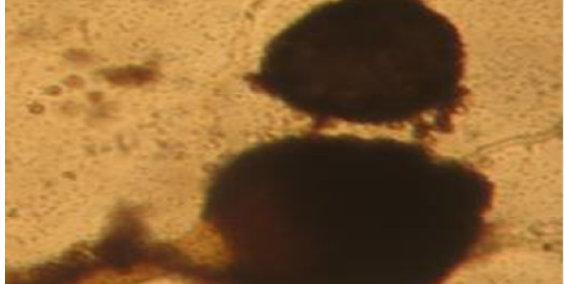
Fig. 1. Micrograph of Aspergillus flavus